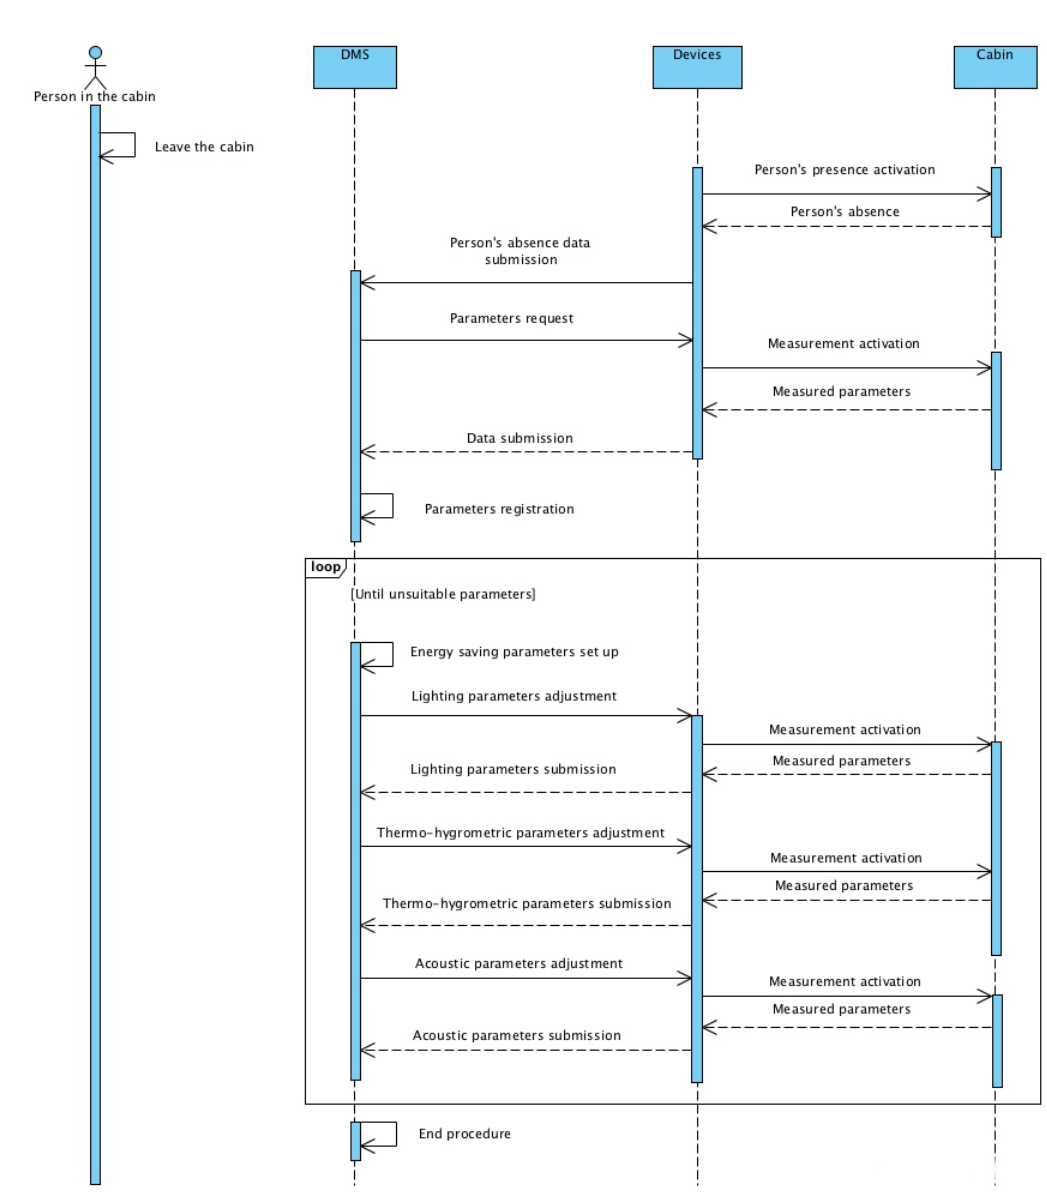
Figure 8. Sequence diagram for the Use Case